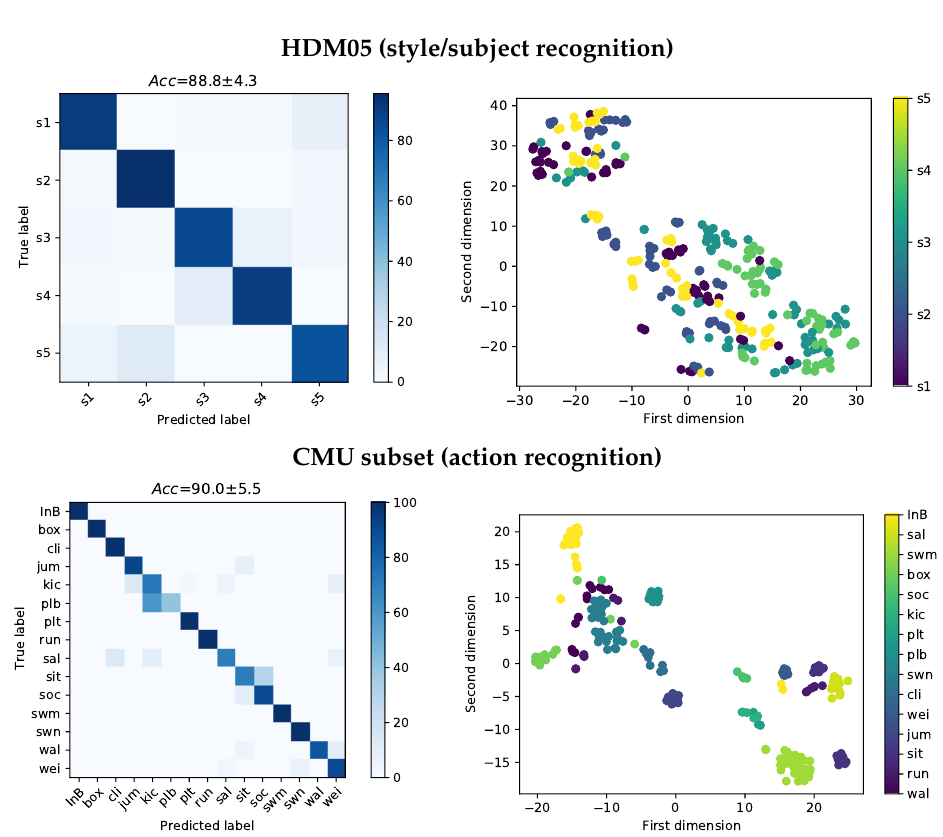
Figure 4. EHECCO-based classification results for HDM05 and CMU subset databases. Top left : HDM05’s confusion matrix (style/subject recognition). Top right : HDM05 t-SNE-based 2D projection from EHECCO distance. Bottom left : CMU subset’s confusion matrix (action recognition). Bottom right : CMU subset t-SNE-based 2D projection from EHECCO